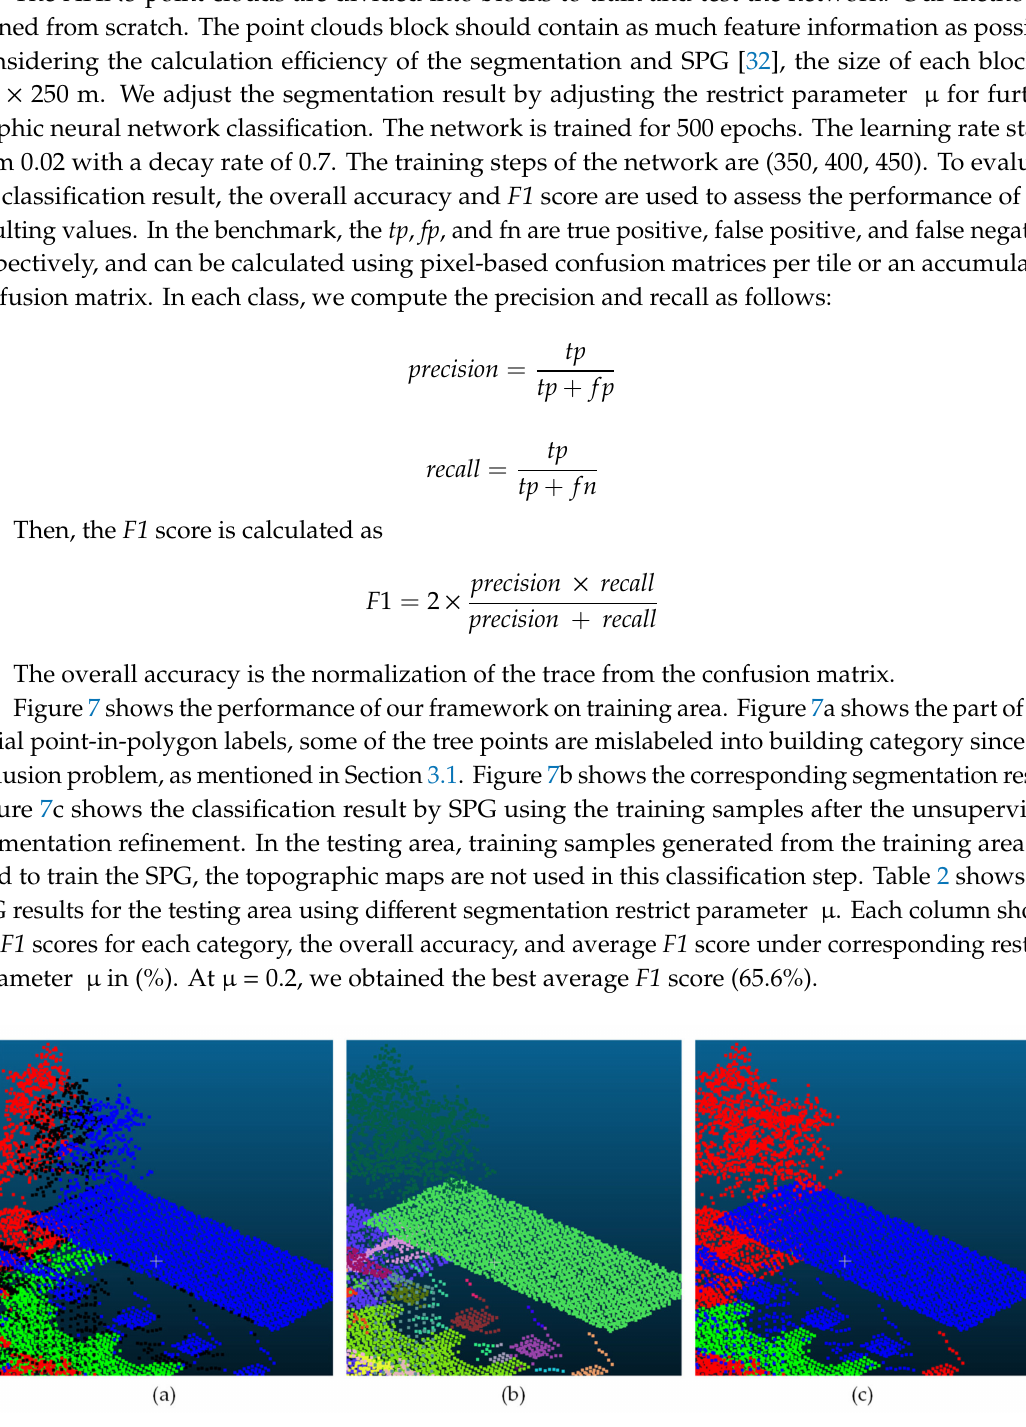
Figure 7. Performance of our framework in the training area. ( a ) Initial point-in-polygon labels; ( b ) Unsupervised segmentation result; ( c ) Classification result by SGP. Building, navy blue; tree, red; terrain, green; unlabeled,